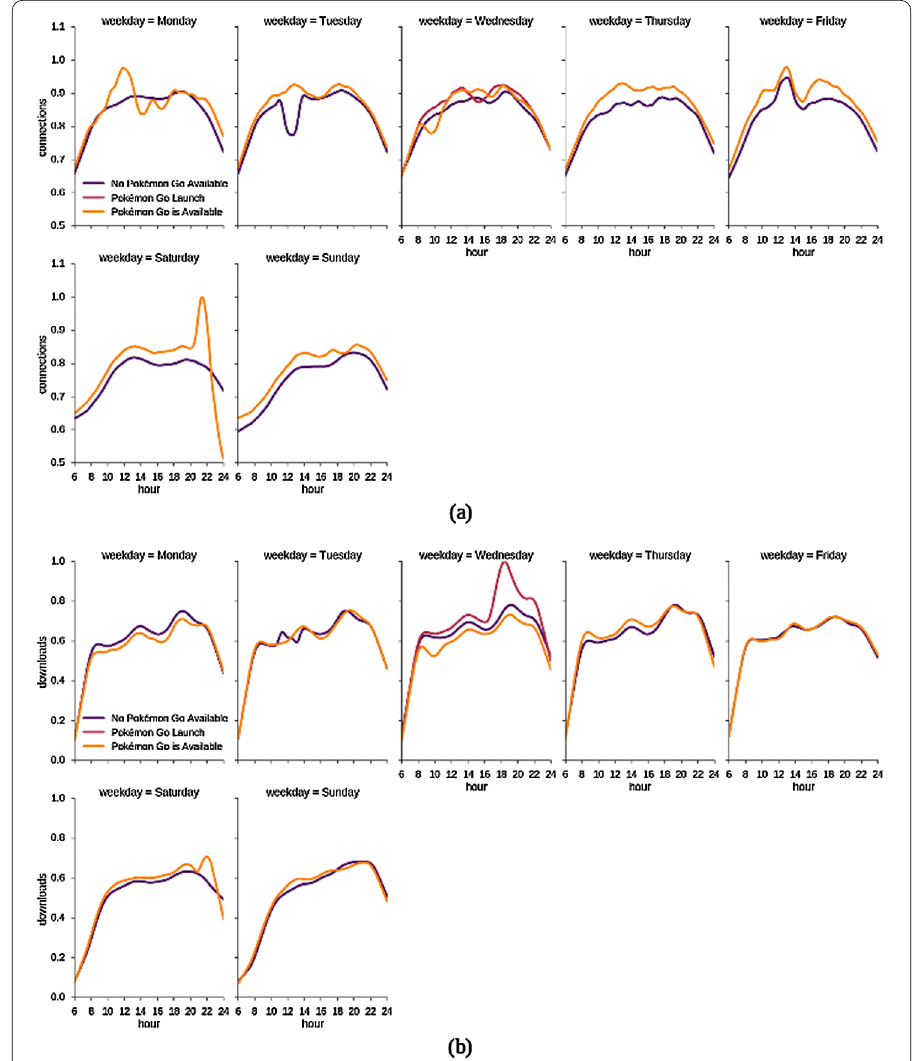
Figure 3 LOWESS time-series of normalized number of connected devices (a) and normalized total downloaded information (b), per minute, for all days in the dataset. The distributions are normalized by dividing the actual number of connections by the global maximum value. Each panel represents a different nominal day, with curves for a day before/after the launch of Pokémon Go. Wednesdays include an additional day that represents the launch of the